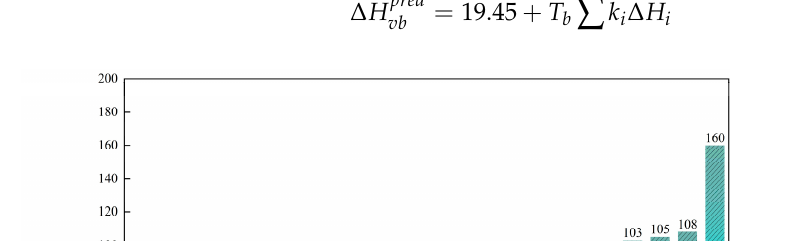
Figure 2. Categories and numbers of organics used in the regression equation process.